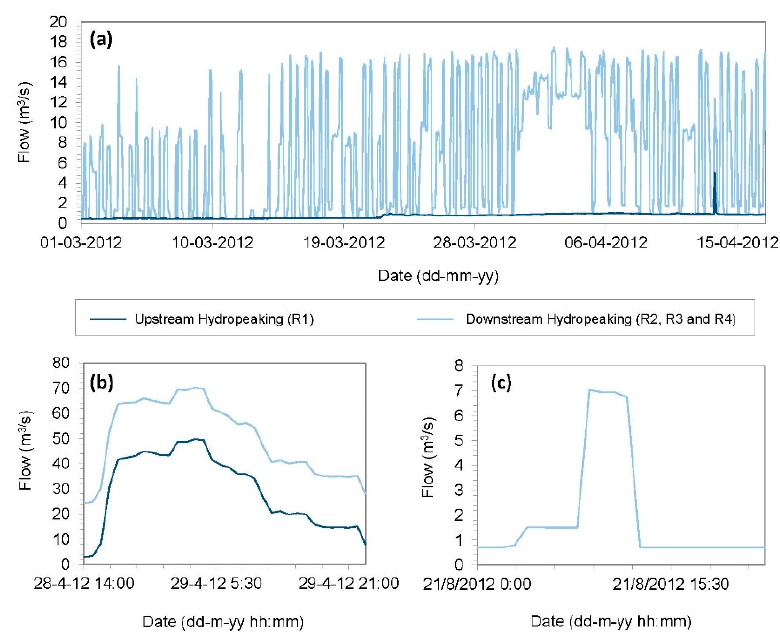
Figure 8. Flow scenarios taken to characterise river’s regime in the Noguera Pallaresa: ( a ) Small magnitude flood and hydropeaking (Scenario 1); ( b ) High magnitude flood and hydropeaking (Scenario 2); and ( c ) A single Hydropeak (Scenario 3).